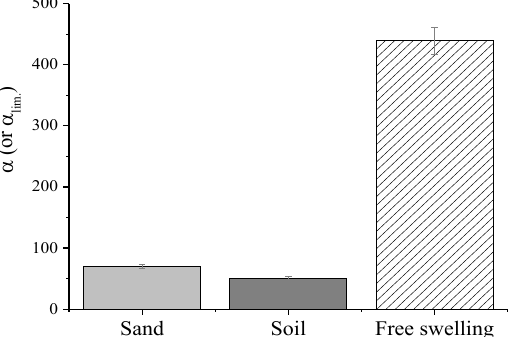
Figure 3. The degree of ACP# swelling in the free state and after its mixing with sand and soil. 0.001 M phosphate buffer; pH 6.5. M phosphate buffer; pH 6.5.